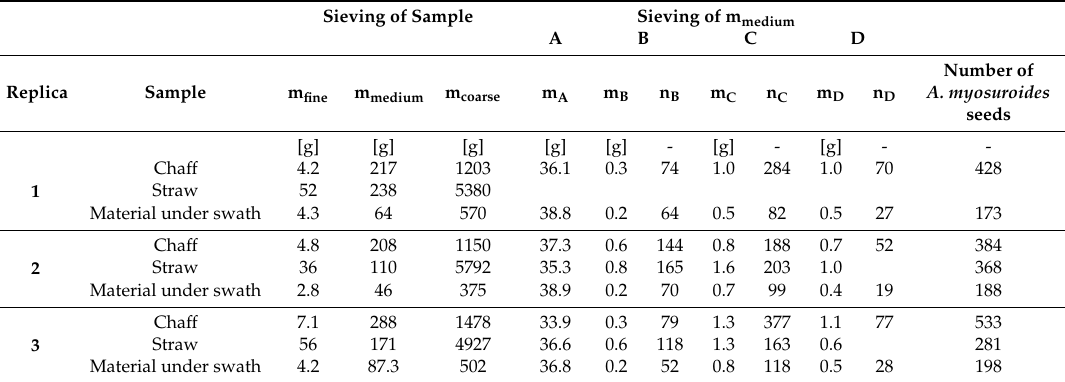
Table 2. Results of sieving experiments (indices belong to fractions sieved by a mesh size of: A >